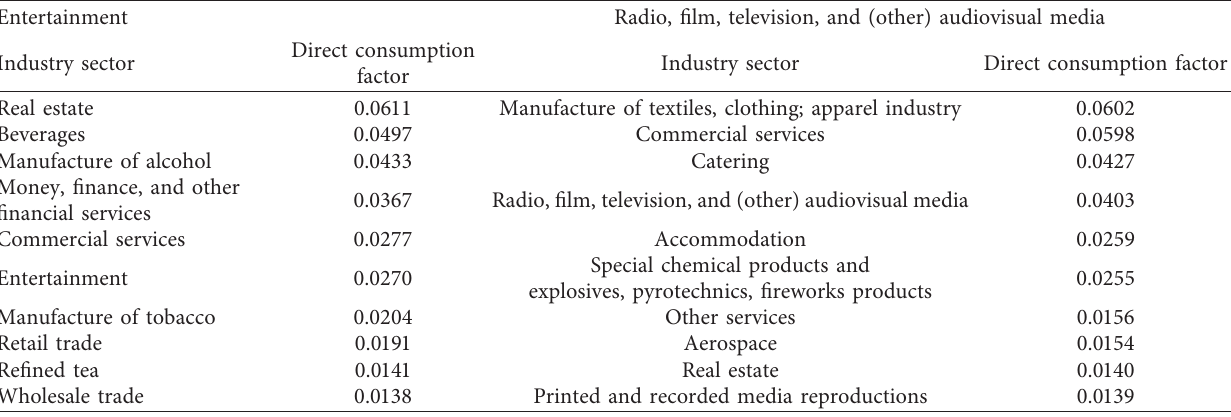
Table 1: Statistical table of direct consumption coefficient of the Chinese entertainment industry on other industrial sectors. Entertainment Radio, film, television, and (other) audiovisual